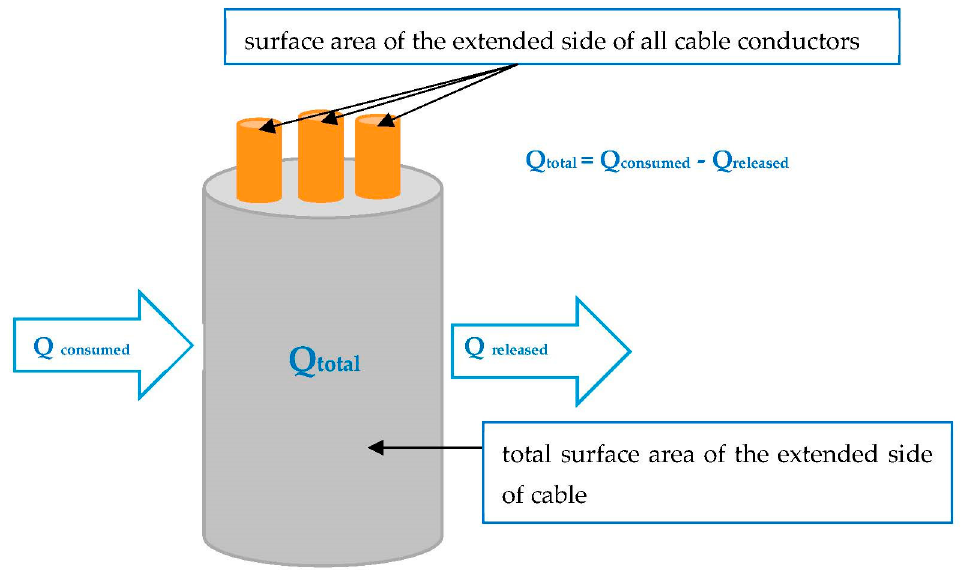
Figure 1. Idealized schematic of heat transfer within the combustion surface area of